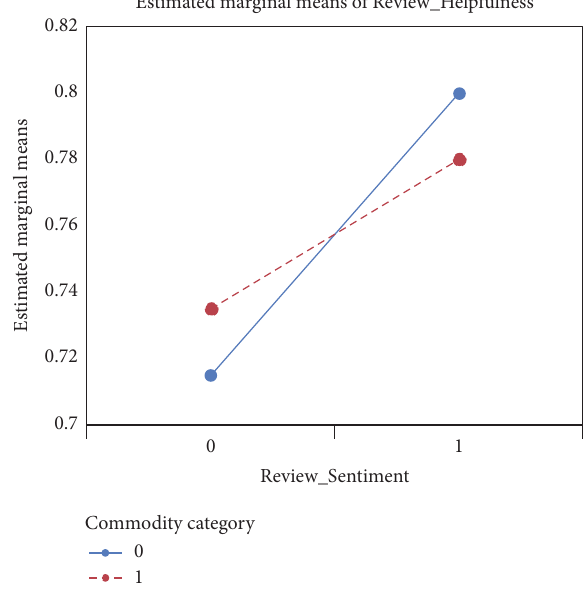
Figure 4: Moderator effect of commodity category.